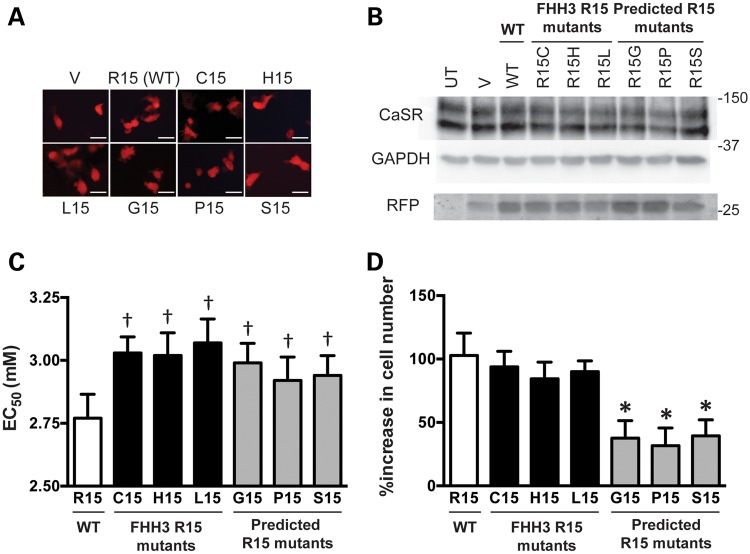
Functional expression of AP2S1 Arg15 (R15) mutants. (A) Fluorescence microscopy of HEK293 cells stably transfected with CaSR and transiently transfected with wild-type R15 (WT-R15), and FHH3-associated mutants (Cys15, C15; His15, H15; Leu15, L15) or other possible R15 mutants (Fig. 4) (Gly15, G15; Pro15, P15; Ser15, S15), or pBI-CMV4-RFP expression vector only (V). RFP expression in these cells indicates successful transfection and expression by these constructs. Bar indicates 20 μm. (B) Western blot analysis of whole-cell lysates using anti-CaSR, anti-GAPDH and anti-RFP antibodies. The FHH3-mutant AP2σ2 and predicted possible R15 mutant proteins were expressed at similar levels. UT, untransfected cells. (C) Measurement of Ca2+i responses following stimulation with varying Ca2+o concentrations revealed cells expressing observed FHH3-associated mutants or the non-observed possible R15 mutants (Fig. 4) to have significantly raised EC50 values when compared with cells expressing the wild-type AP2σ2 (WT-R15) protein. Results are from eight to ten assays and three independent transfections. (D) Growth of cells expressing WT or mutant AP2σ2 proteins. Cells expressing the non-observed possible R15 mutants showed a significantly reduced percentage increase in cell numbers over a 24-h period when compared with cells expressing WT or FHH3-associated mutant AP2σ2 proteins, consistent with an impairment of proliferation. Results are from 11 to 18 assays and 4 independent transfections. *P < 0.05 and †P < 0.0001.